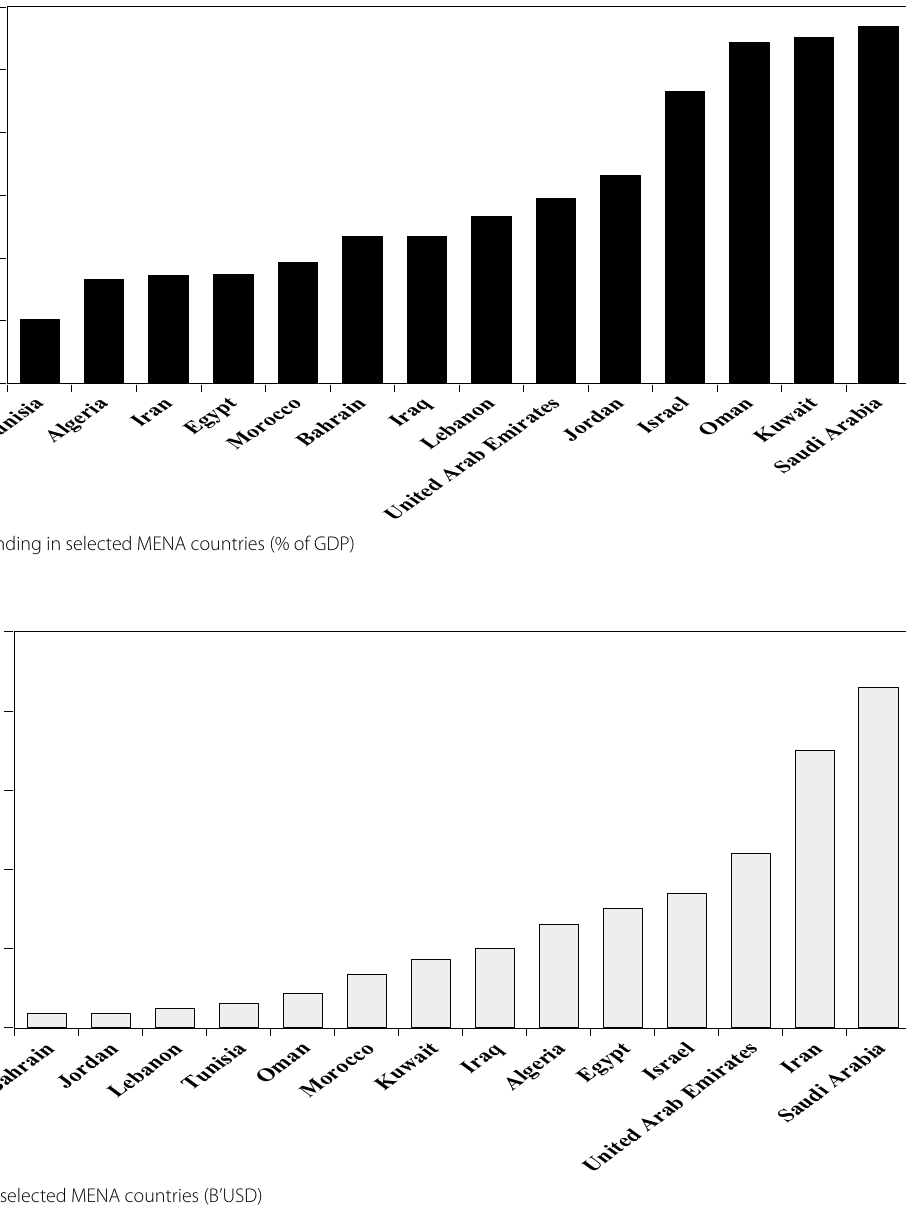
seventh, eighth, ninth and tenth, respectively. Tunisia has the least military burden.